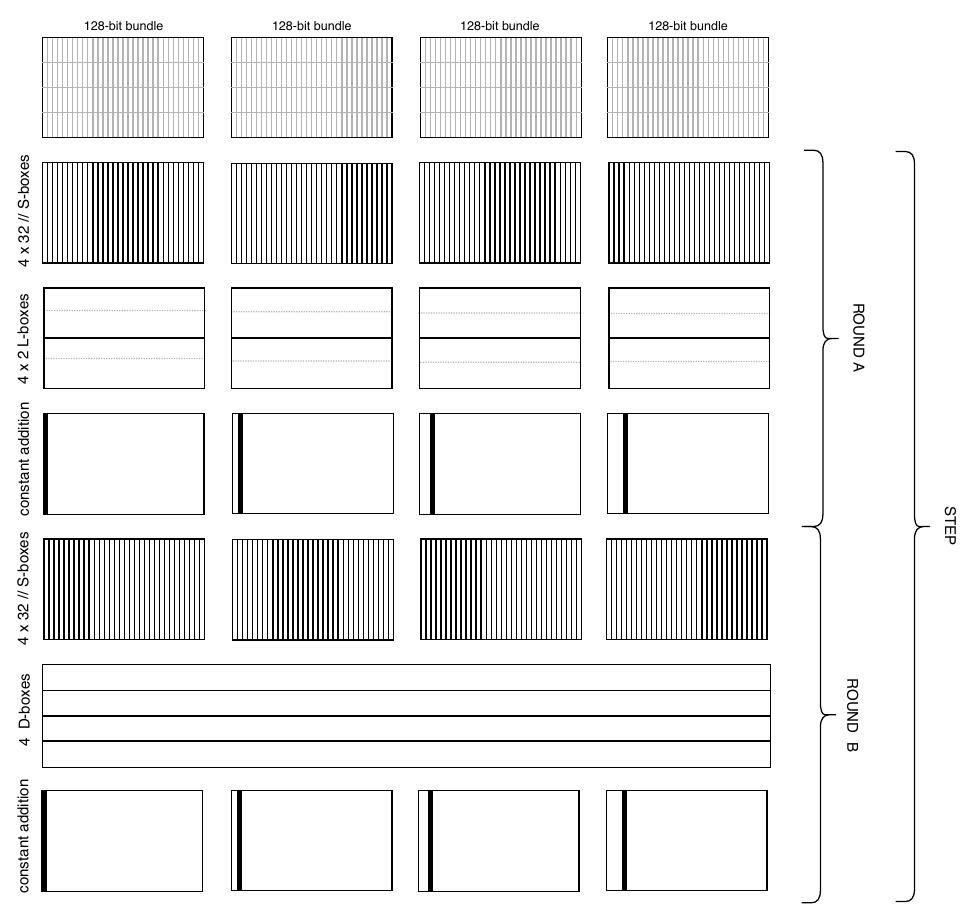
Figure 5: Round and step of Shadow-512 : high-level